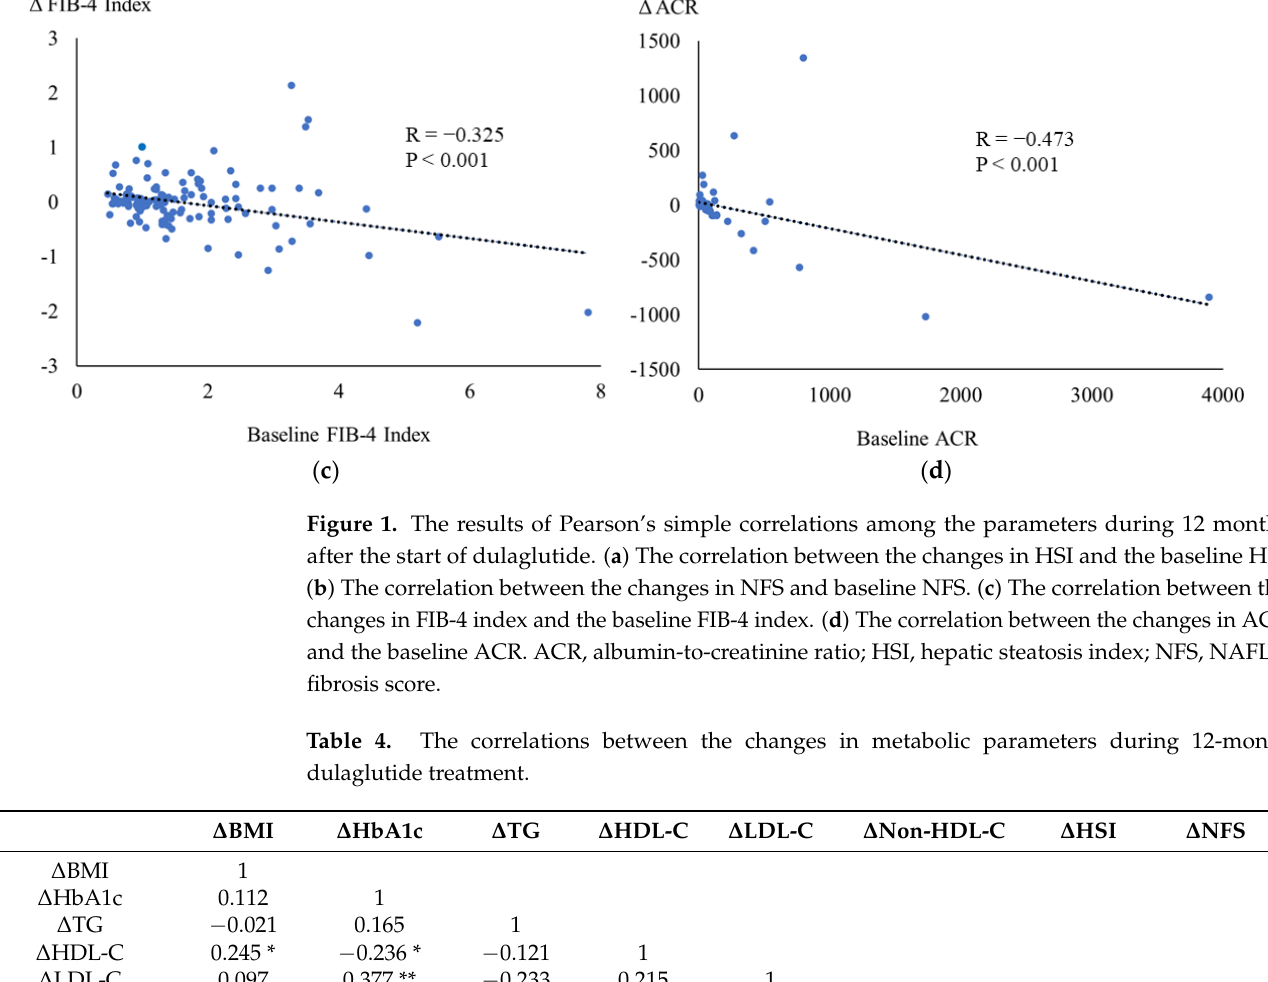
Table 4. The correlations between the changes in metabolic parameters during 12-month dulag- lutide treatment.